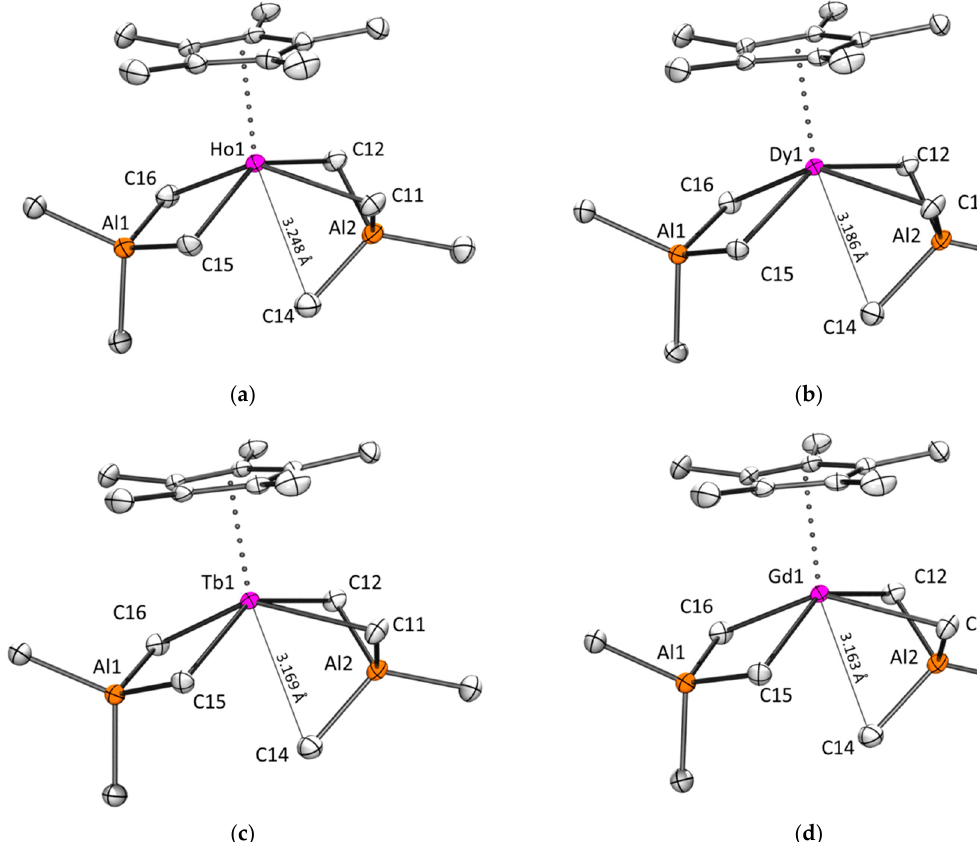
Figure 1. ORTEP view of the crystal structures of [Cp*Ln(AlMe 4 ) 2 ] ( 1 Ln , Ln = Ho ( a ), Dy ( b ), Tb ( c ) and Gd ( d )). Atomic displacement parameters are set at the 50% probability level. Hydrogen atoms are omitted for clarity. See Table 1 for significant bond lengths and angles.